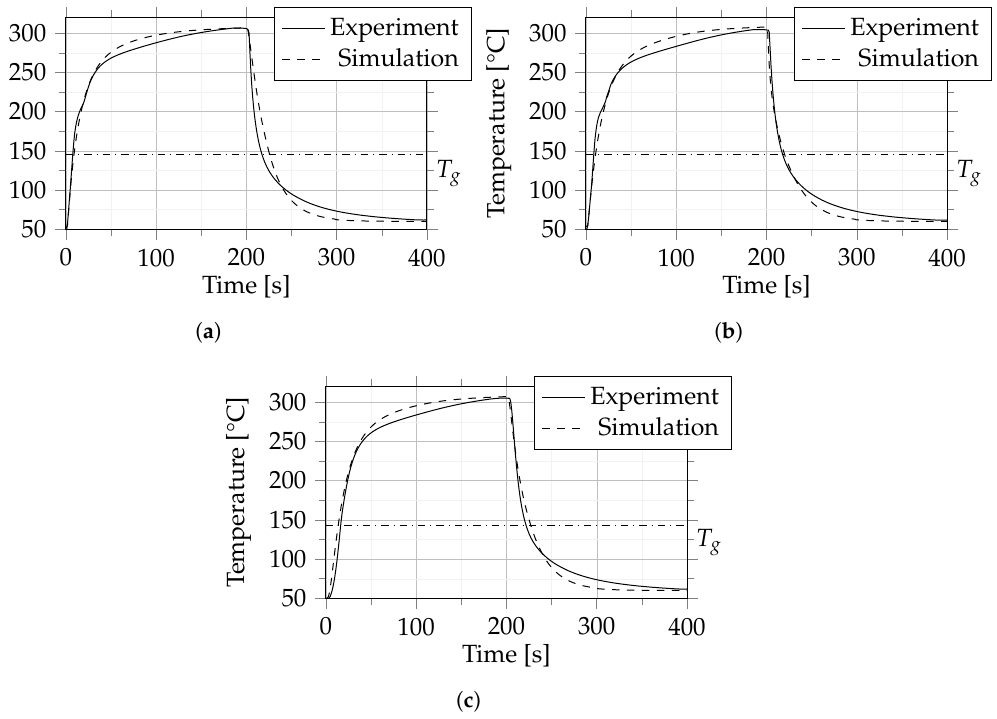
Figure 13. Case 4: Comparison between experiment and simulation in terms of temperature between layers 1 and 2 ( a ), 9 and 10 ( b ) and 17 and 18 ( c ). The dash-dotted line indicates the glass transition temperature ( T g ) of 145